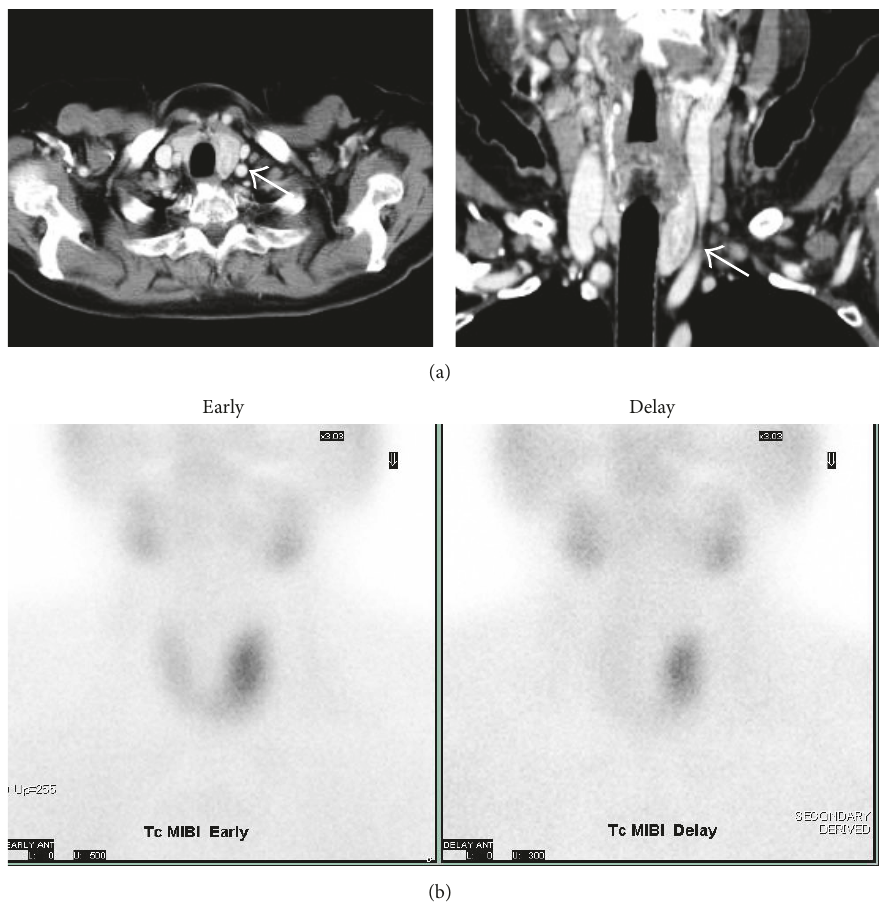
Figure 1: (a) Computed tomography of the neck. The scan with contrast enhancement shows a large heterogeneous soft tissue mass (28mm transverse diameter), clearly defined, within the left thyroid lobe (white arrow). (b) 99 m Tc-MIBI scintigraphy. Early and delayed scintigrams reveal focal accumulation of increased radiotracer uptake in the left lobe of the thyroid.